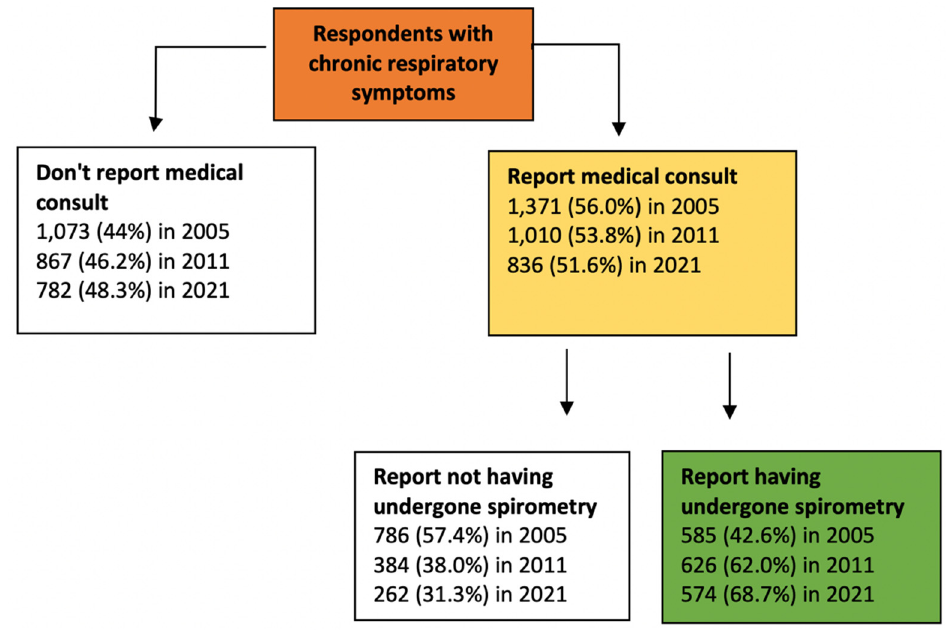
Figure 2. Changes in diagnostic flow of chronic respiratory symptoms in the Spanish population interviewed in 2005, 2011, and 2021.